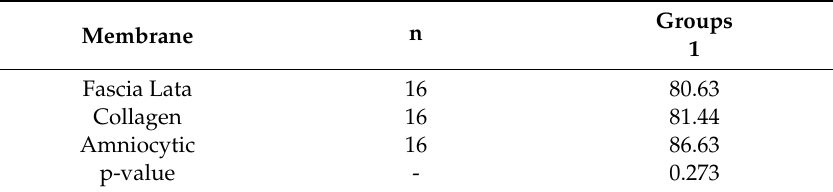
Table 7. Tukey HSD test. The means of di ff erences in radiological density percentages for the groups in homogeneous subsets are